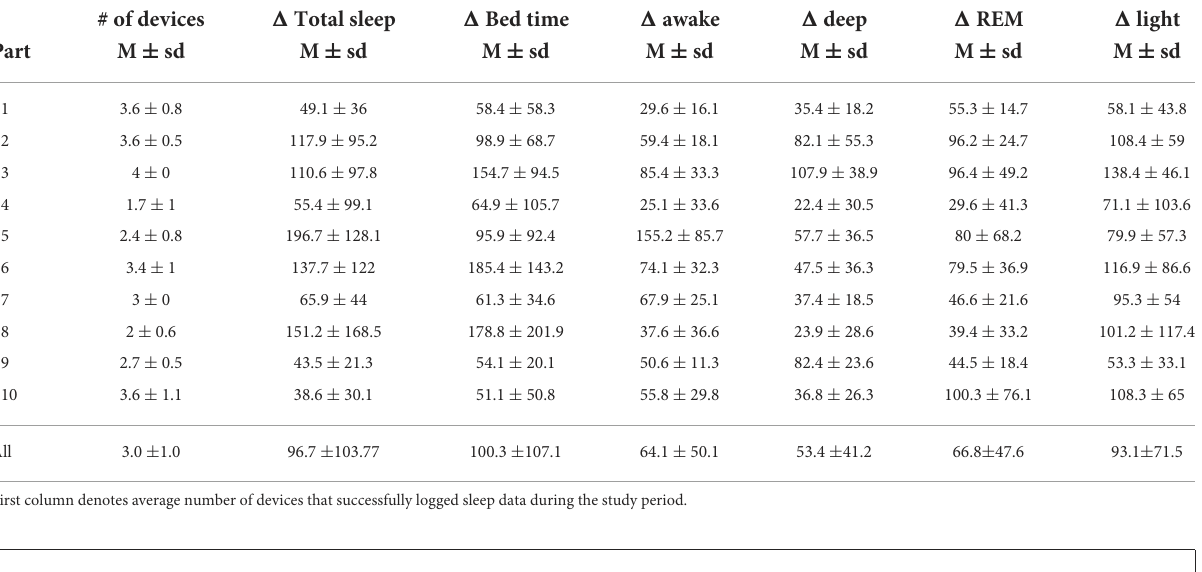
P9, the devices give somewhat similar results, but P5 and P8 have versatile results for each night. The collected data between